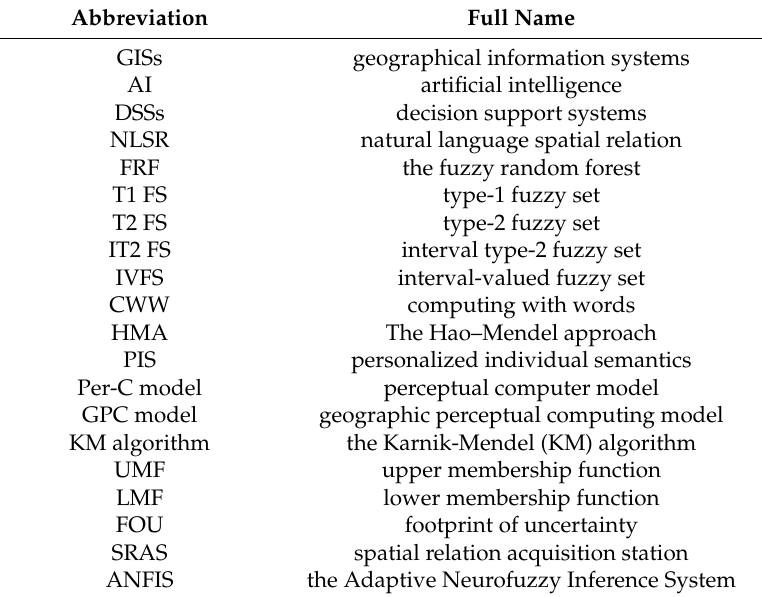
Table A1. Abbreviations and their